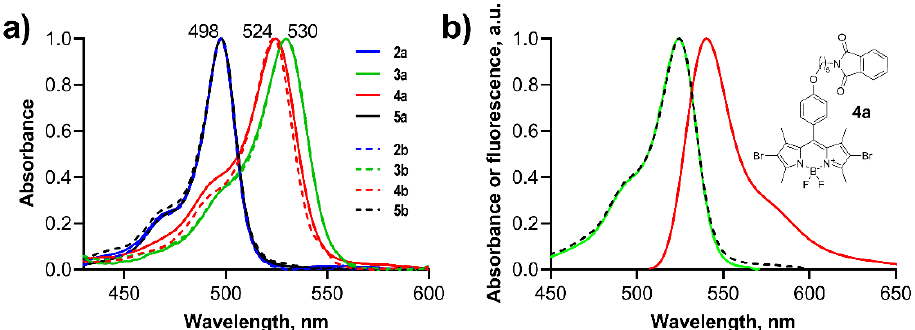
Figure 1. ( a ) Normalized absorption spectra of target compounds in MeOH (c = 1 µ M); ( b ) Normalized absorption (black, dashed), emission (red), and excitation (green) spectra of 4a in MeOH (c = 1 µ M).